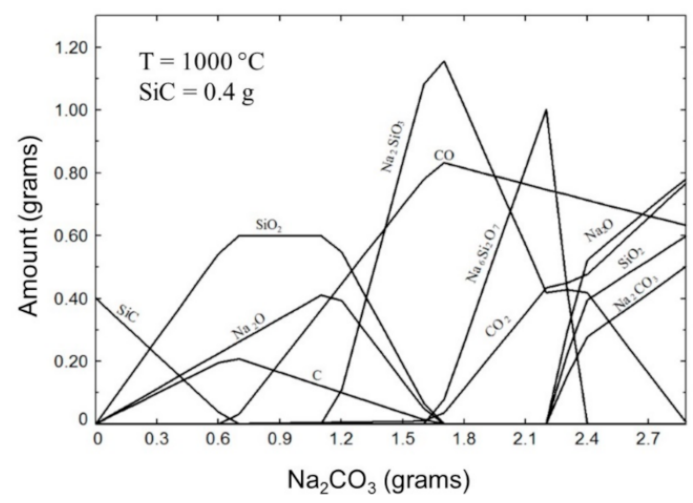
Figure 11. Amount of sodium silicate compounds formed by the interaction between 0.4 g of SiC and different amounts (from 1.5 to 2.8 g) of Na 2 CO 3 at 1000 ◦ C, calculated in FactSage